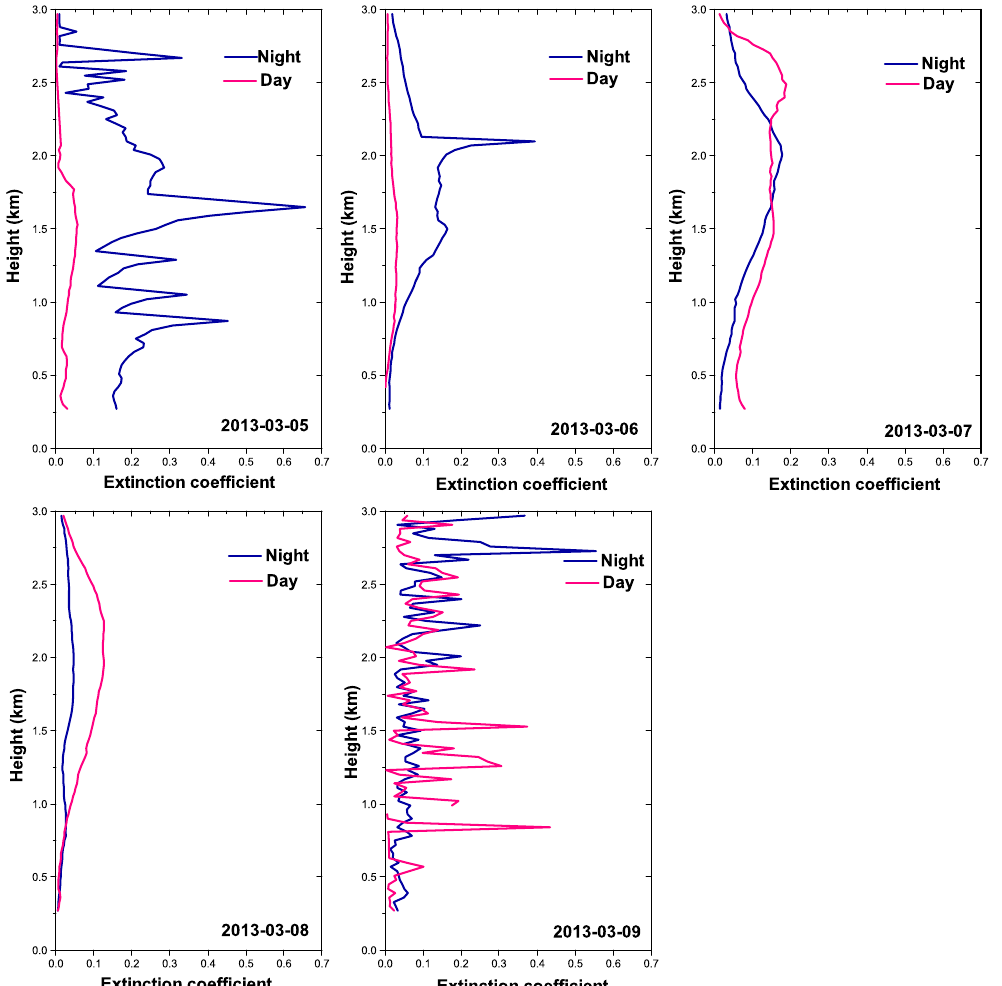
Figure 9. Profiles of aerosol extinction coefficient from MPL-retrieved data averaged for daytime and nighttime during 5–9 March 2013 in